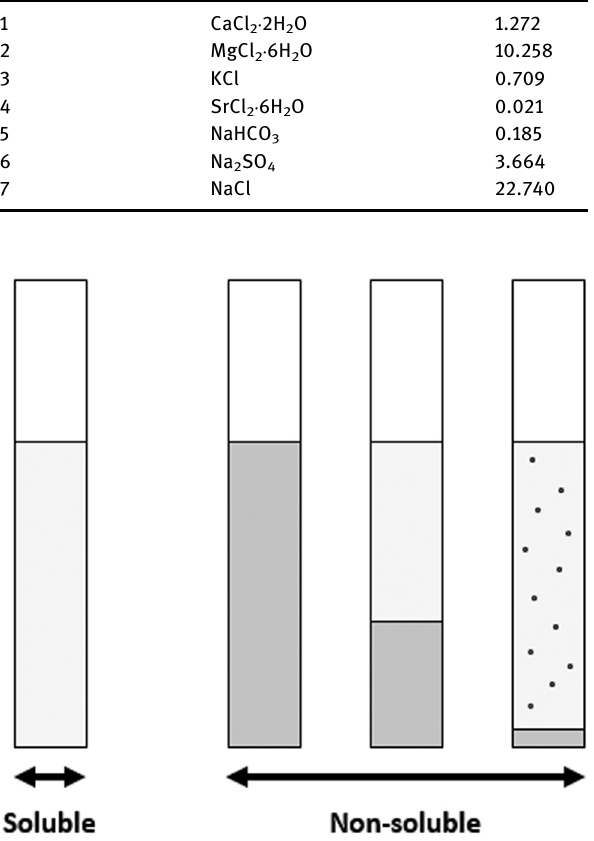
Figure 2: Schematic of solubility and compatibility evaluation.